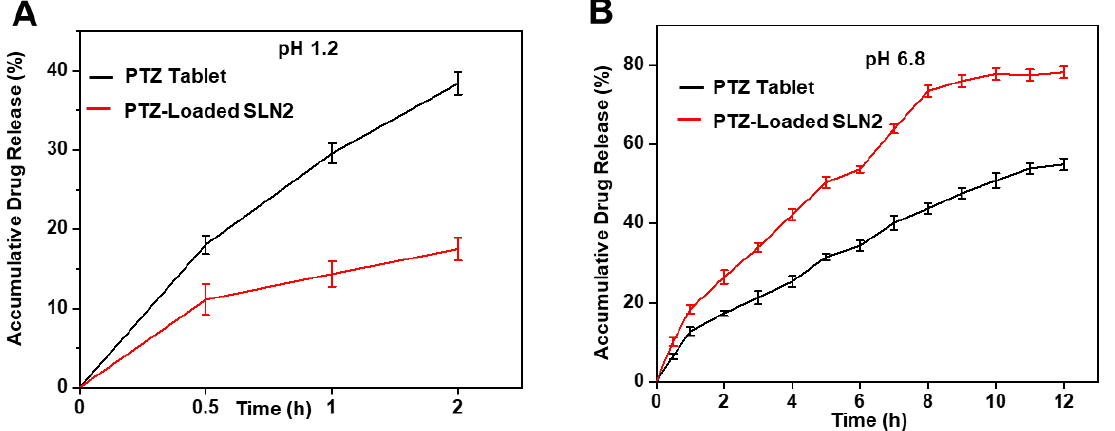
Figure 4. In vitro drug release profile of PTZ-loaded SLN2 and marketed PTZ tablets, using the dialysis-bag method in simulated conditions. ( A ) In SGF (0.1N HCl, pH 1.2) for 2 h; ( B ) in saliva-like condition (1 × PBS, pH 6.8) for 12 h. Data are expressed as mean ± SD (n = 3). Mild statistical significance ( p < 0.05) was observed during the first 30 min, while moderate statistical significance ( p < 0.01) was observed from 2h.